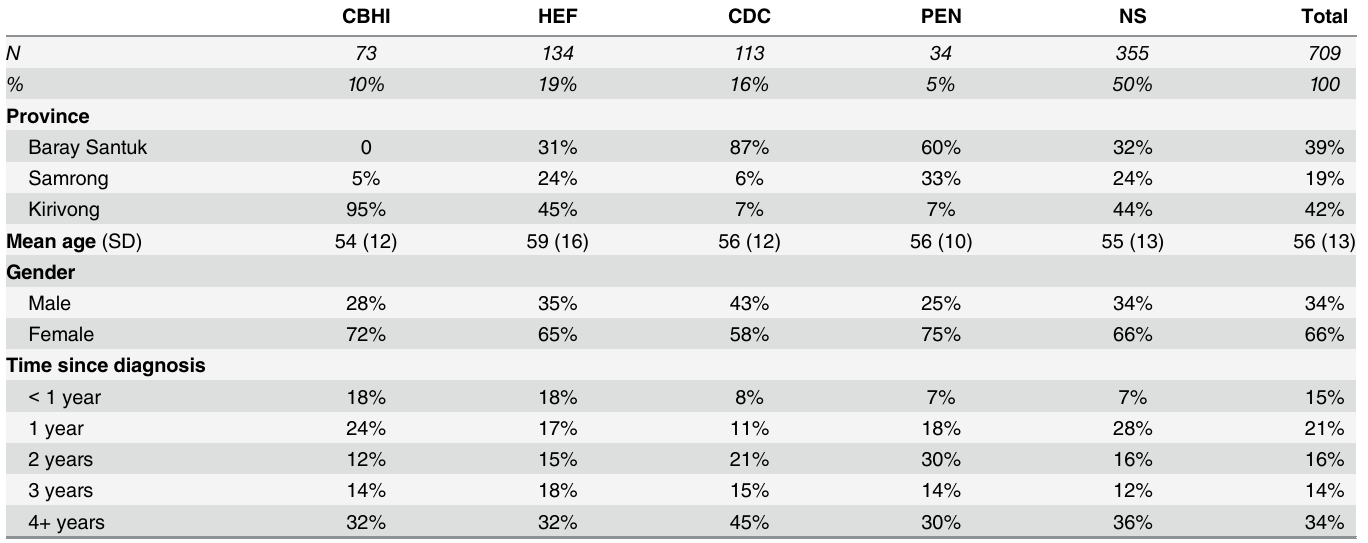
Table 2. Sample characteristics.